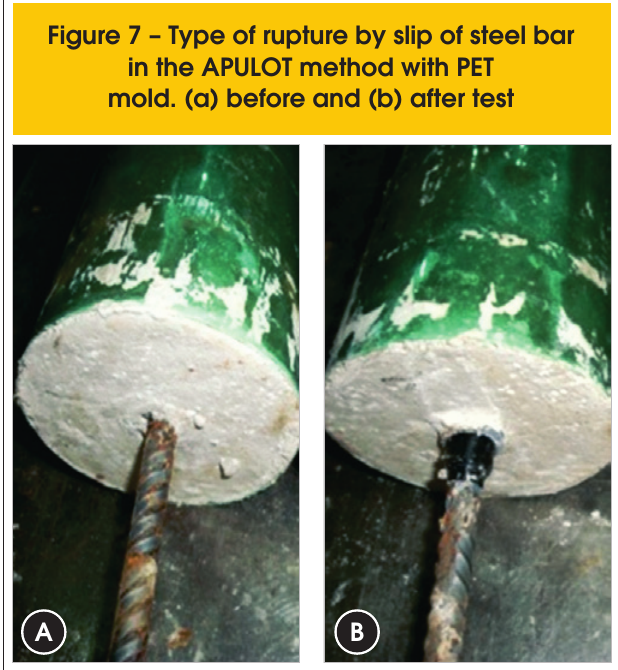
Figure 7 – Type of rupture by slip of steel bar in the APULOT method with PET